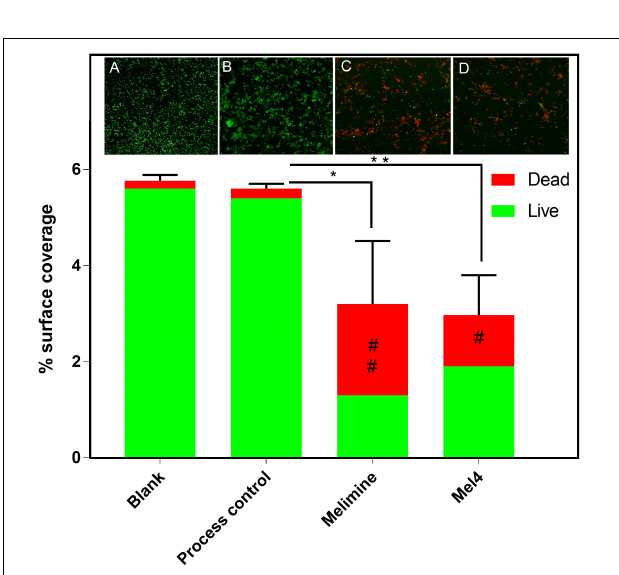
FIGURE 5 | Fluorescence microscopy of bacteria adhered to glass surfaces. Bacterial cells with intact membranes stained green with Syto-9 while bacteria with permeabilized membrane stained red with propidium iodide. Representative images of P. aeruginosa 6294 captured with 40 × objective following incubation for 4 h with (A) blank glass, (B) process control, (C) melimine coated, and (D) Mel4 coated surfaces. Image analysis of the percentage surface area covered by stained bacteria was carried out with ImageJ software. Percentage area covered by live bacteria is represented as green bars and the area covered by dead bacteria represented as red bars. * p = 0.047, ** p = 0.032, # p = 0.073, and ## p = 0.025 compared to process control. Error bars represent means of ( ± SD) of three independent repeats in